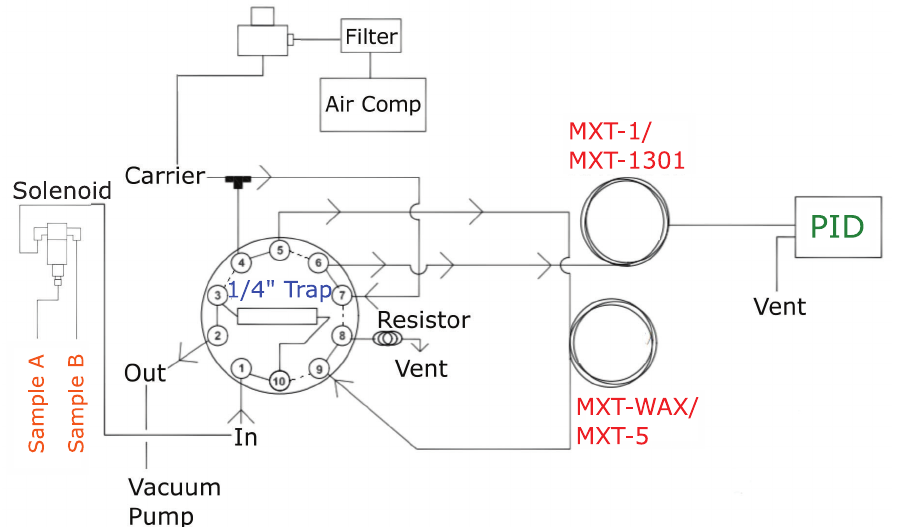
Figure 2. Schematic of the compact GC-PID system operating principle with 10-port valve in “load” position (shown as the solid lines) and “inject” position (shown in the dotted line) in a precolumn backflush configuration. Principal components of the different modules are shown in different colors: sampling (orange), preconcentration (blue), separation (red) and detection